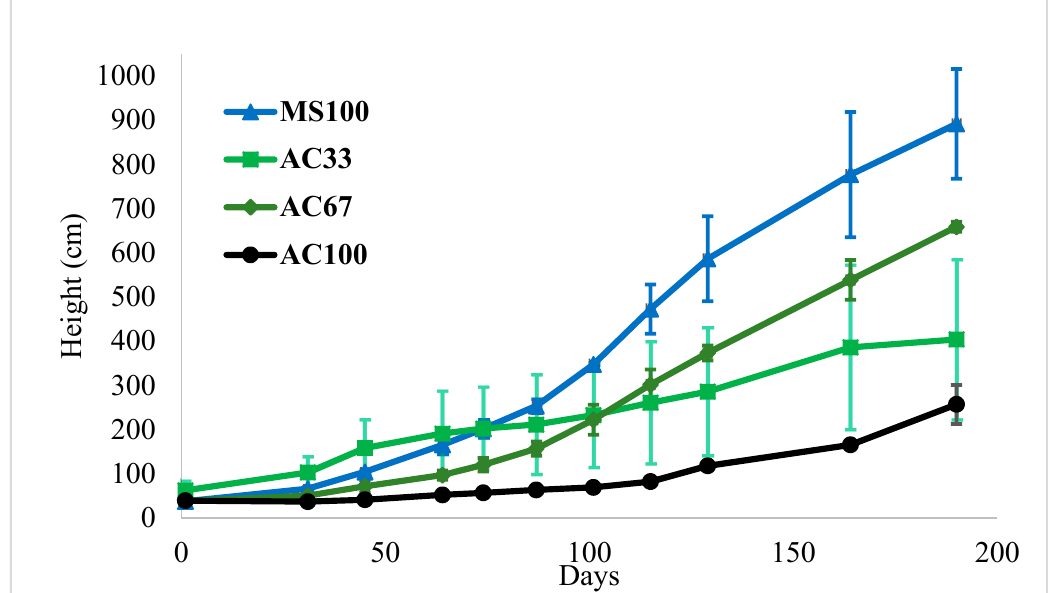
Figure 4. Accumulative total stems height on different Plant-MFC reactors.